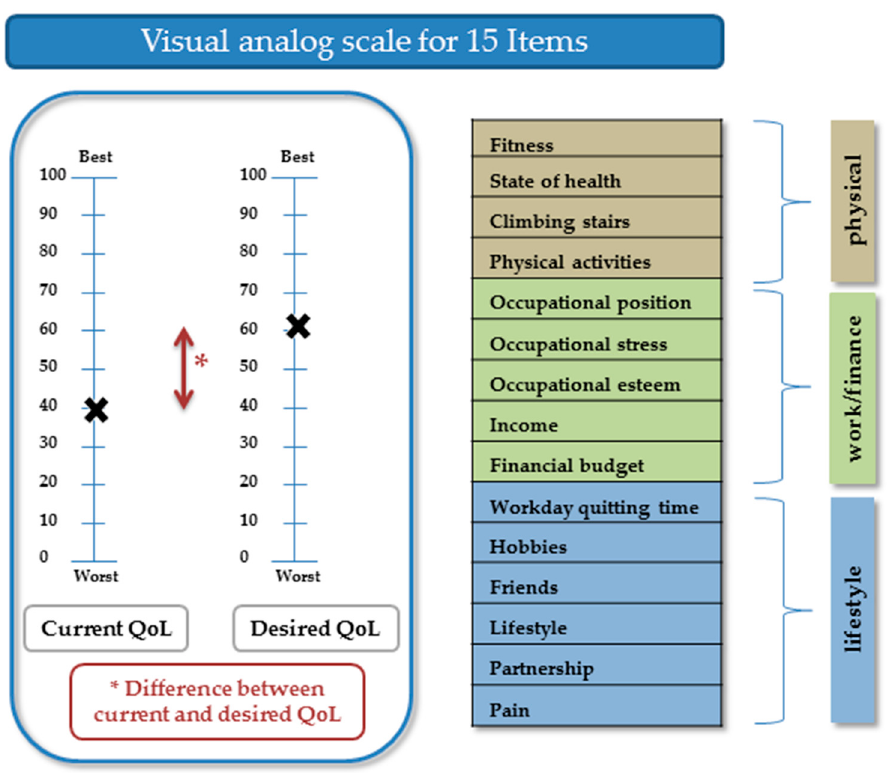
Figure 1. Quality of Life questionnaire. For the fifteen quality of life (QoL) questions, participants marked two visual analogue scales: one for current QoL and the other for desired QoL. A score of 100 indicated the best quality of life, while a score of 0 indicated the worst.